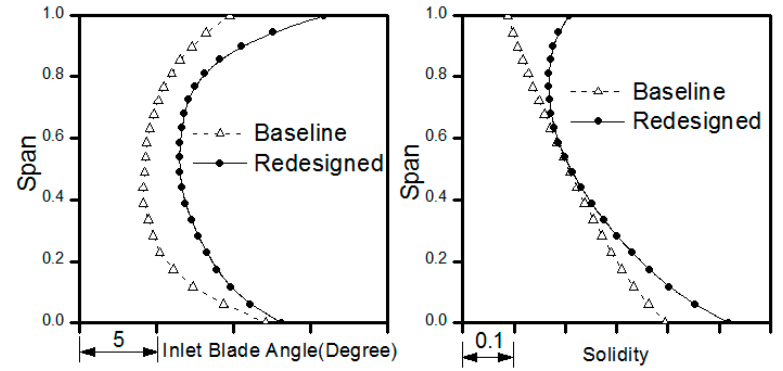
Figure 16. Inlet blade angle and solidity profiles of the baseline and redesigned stator 5.